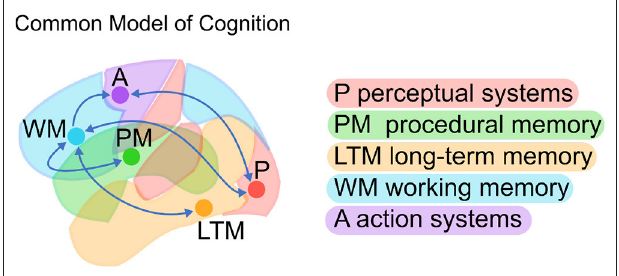
FIGURE 1 | The Common Model of Cognition (CMC; Adapted from Laird et al.,